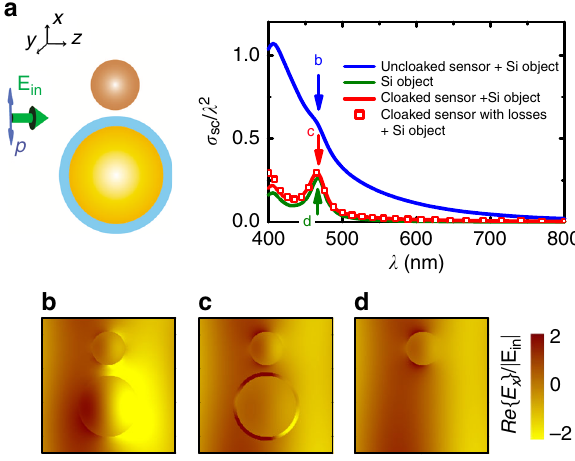
Fig. 4 ‘ See-through ’ invisible tachyonic sensor. a Plotted vs. visible wavelengths is the total cross section (blue line) of the combined system of an uncloaked detector (lower part of left inset, without the cloak) in close proximity (30 nm distance) to a Si object (top part of inset) — where, both, the dispersive and absorptive properties of Si have been taken into account according to experimental data [e.g., D. E. Aspnes, “ Properties of silicon, ” EMIS Datareviews 59 ]. Also shown are the total cross section ( σ = σ + tot sc σ abs ) of the two-object system shown in the inset, illuminated with light polarized parallel to the system ’ s axis, without (red solid line) and with (red symbols) realistic sensor losses (Im{ ε sensor } = 0.01), for a gap distance of 20 nm, and the total cross section for the isolated Si sphere (green). b – d Corresponding electric- fi eld pro fi les for the cases pointed out with arrows in ( a ), calculated on the basis of fi nite-element (Comsol) full-wave causal simulations. Note in ( c ) the penetration of the incident fi eld inside the region of the cloaked object, unlike transformation-optics cloaks, making the object capable of ‘ seeing through ’ the cloak its surrounding environment, with virtually no perturbation of the fi eld around the sensed (top) object (compare the fi eld around the object in ( c ) and in ( d